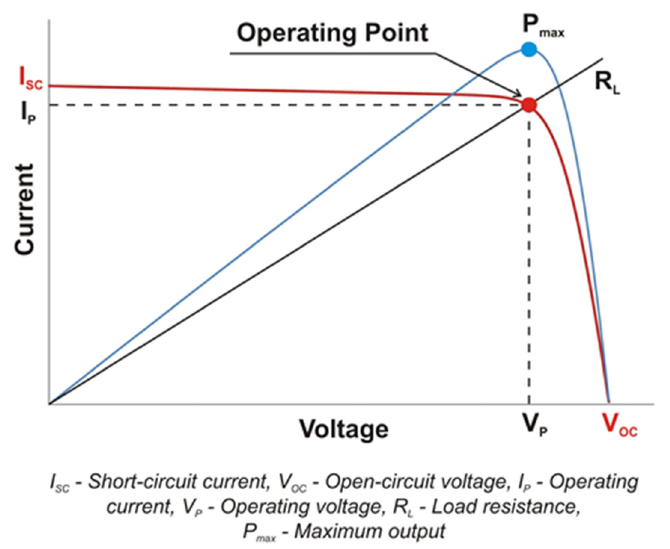
Figure 6. Basic current-voltage ( I-V ) characteristic of PV panel